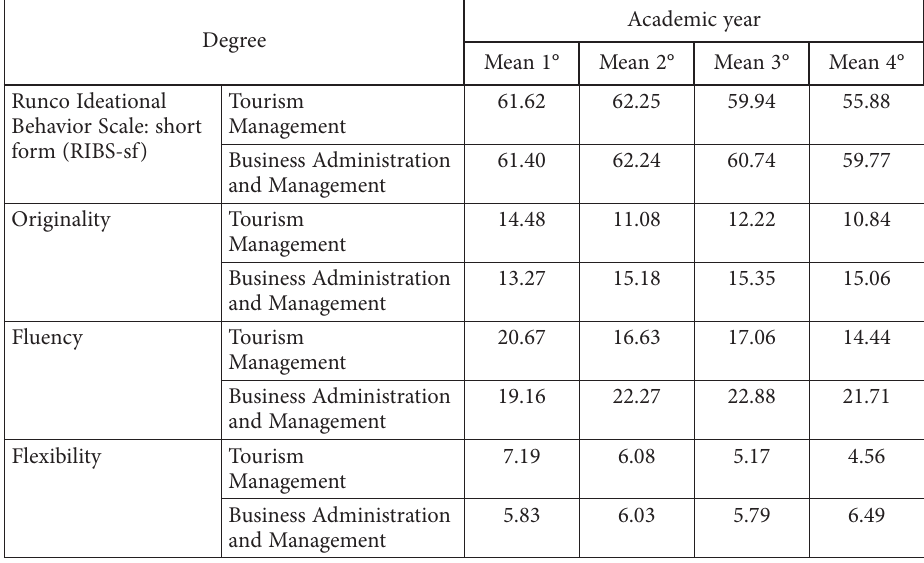
Table 4. Mean for each degree according to academic year (source: created by authors) Degree Mean 1° Mean 2° Mean 3° Mean 4° Runco Ideational Behavior Scale: